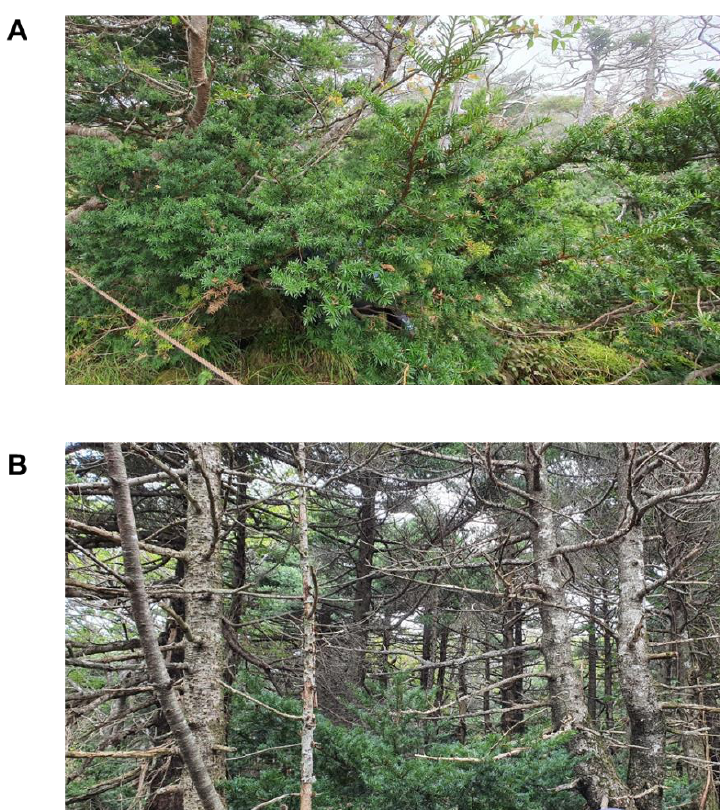
Figure 8. Images of Korean fir trees ( Abies koreana ) used for sample collection in this study. ( A ) Healthy looking stable trees and ( B ) die-back-affected standing dead trees.